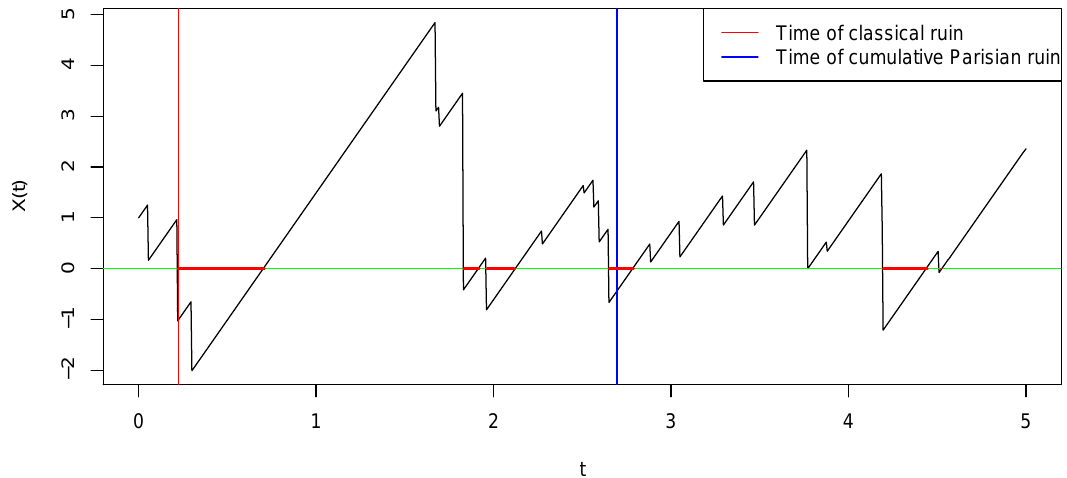
Figure 1. A sample path of a Cramér–Lundberg process X t . The time of ruin τ − of cumulative Parisian ruin κ r is in